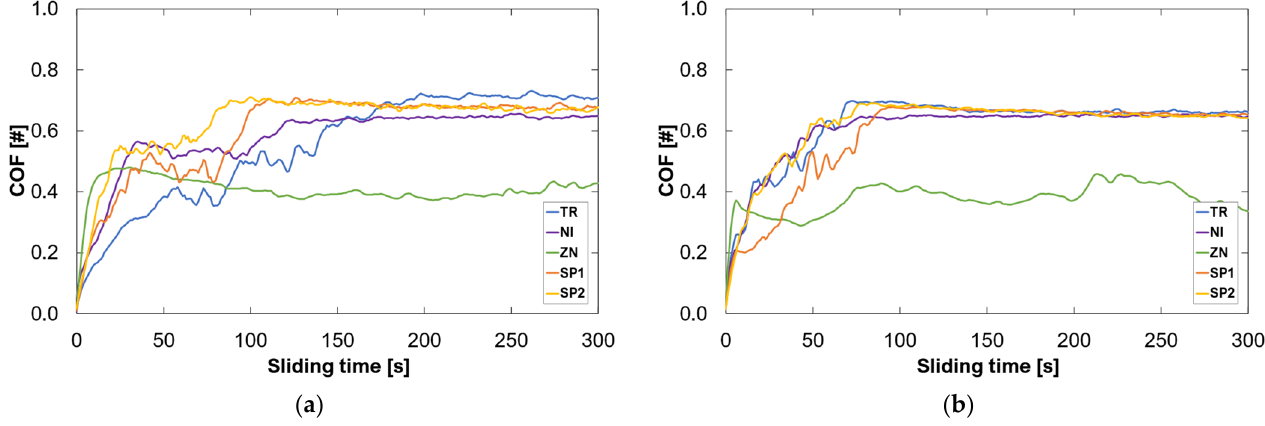
Figure 7. Evolution of COF during IT-IR tests, run-in stage: ( a ) 1 Hz and ( b ) 2 Hz sliding frequency. Table 6. IT-RI stage tests transition time, steady COF values, and COF’s coefficient of variation.